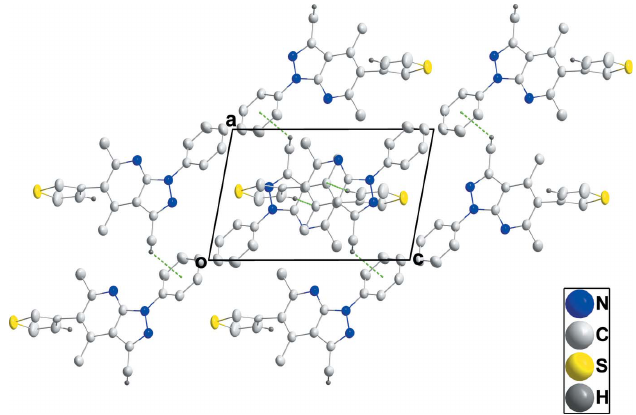
Figure 3 Packing viewed along the b -axis direction with intermolecular inter- actions depicted as in Fig. 2.